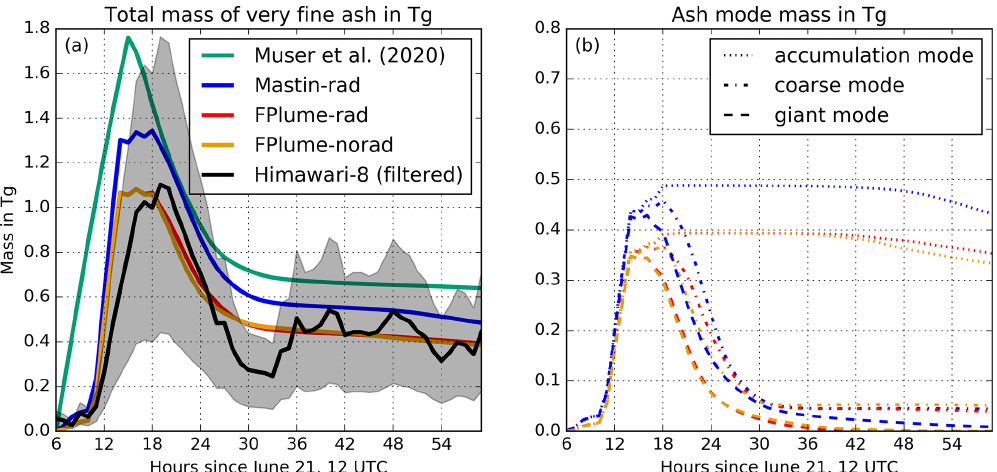
Figure 4. (a) Temporal evolution of the total amount of very fine ash in the atmosphere (Tg) for Himawari-8 observations (black) with an estimated uncertainty range (gray shading). Simulation with one constant emission phase (green, after Muser et al., 2020). Simulation with ICON-ART with and without aerosol–radiation interaction, each with phase-dependent FPlume MERs and a very fine ash fraction derived from the relationship by Gouhier et al. (2019) (red and yellow). Simulation with ICON-ART, eruption-phase-dependent Mastin MERs, and the same very fine ash fraction as for the red curve (blue). (b) Temporal evolution of the simulated mass for the different ash modes (dotted for accumulation modes, dash-dotted for coarse modes, and dashed for the giant mode). The colors refer to the model experiment shown in the panel (a) .